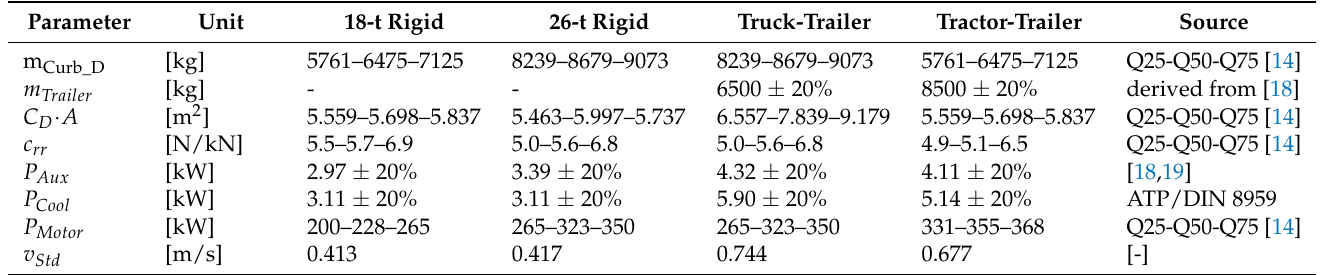
Table 1. Truck-class-specific simulation parameters. Ranges indicate the PERT distribution’s mini- mum, most likely, and maximum values. Individual parameters are constant values.